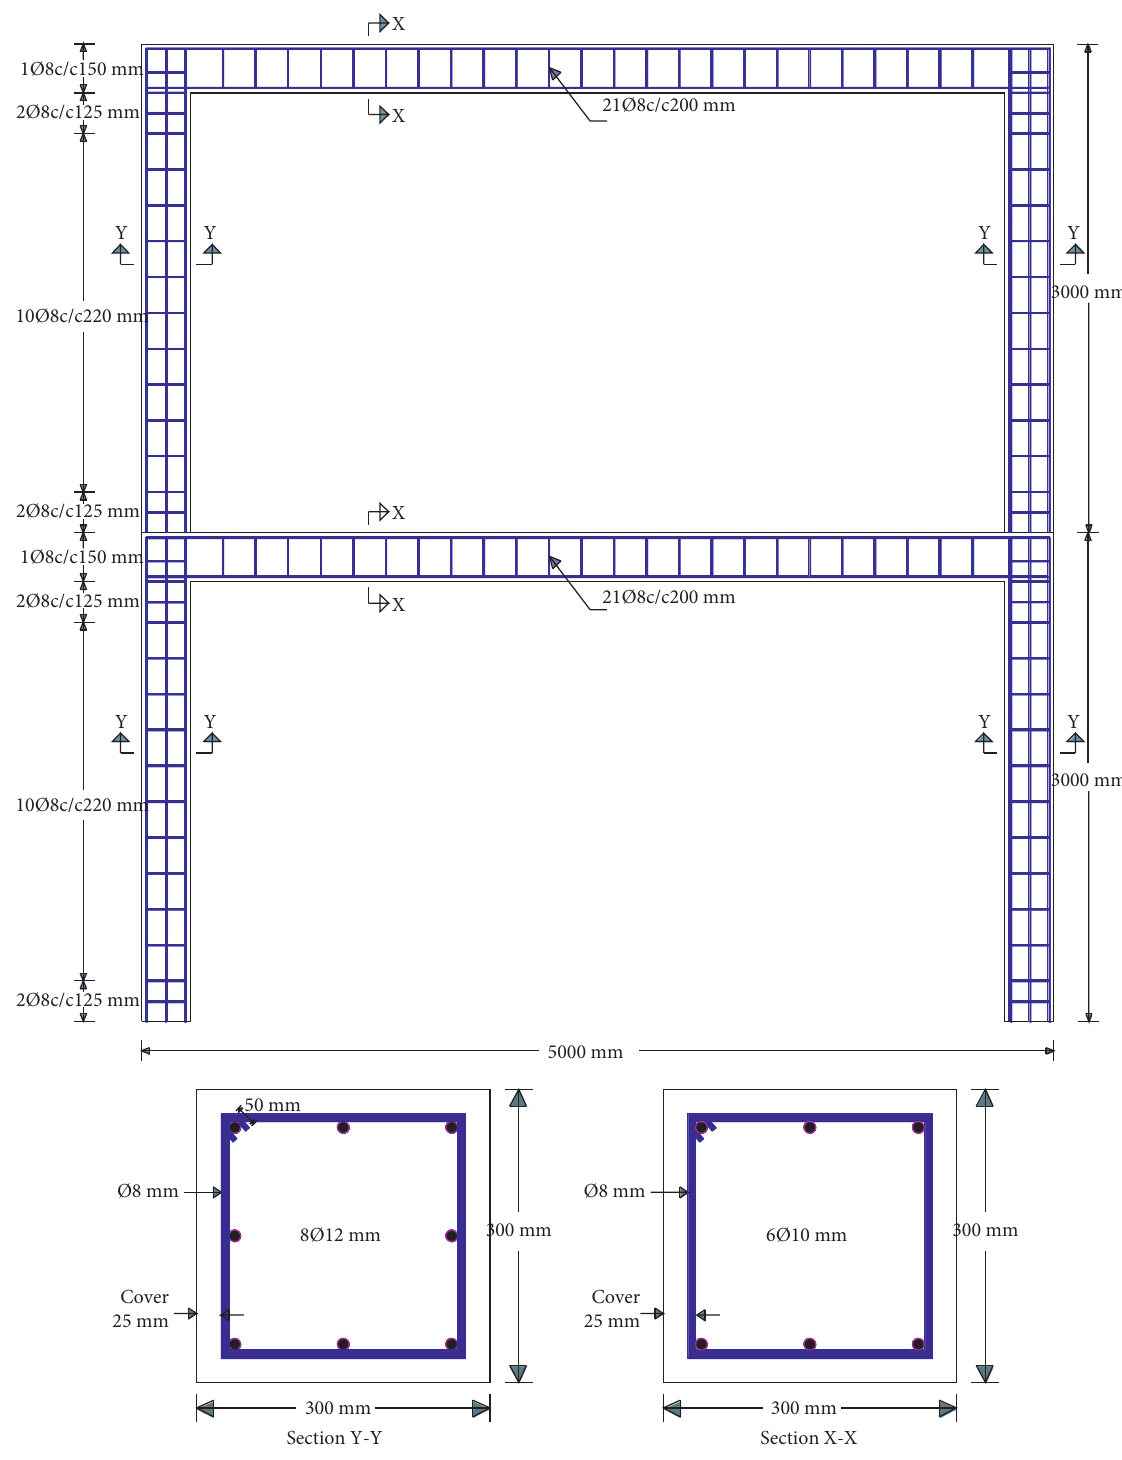
Figure 9: Reinforcement detailing for